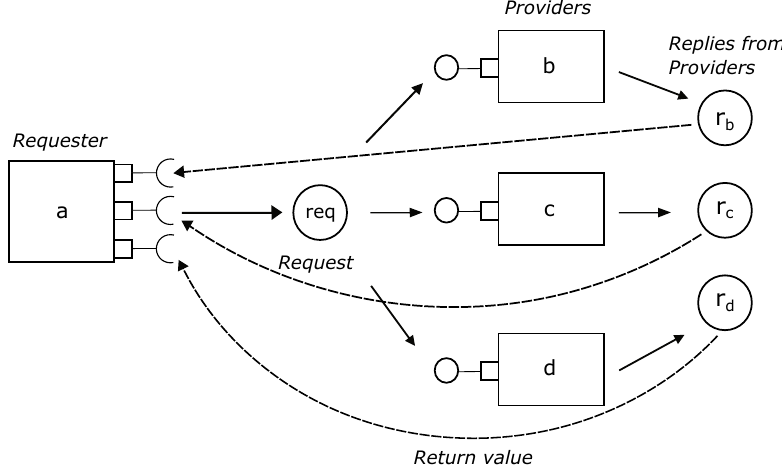
Figure 3. Modifying object a in Figure 1 to receive replies from multiple